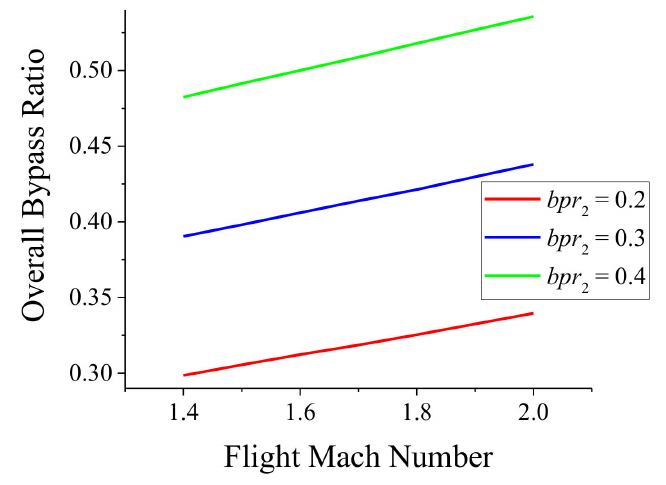
Figure 15. The Variations of Overall Bypass Ratio at the conditions of Different Second Bypass Ratios ( bpr 2 ).